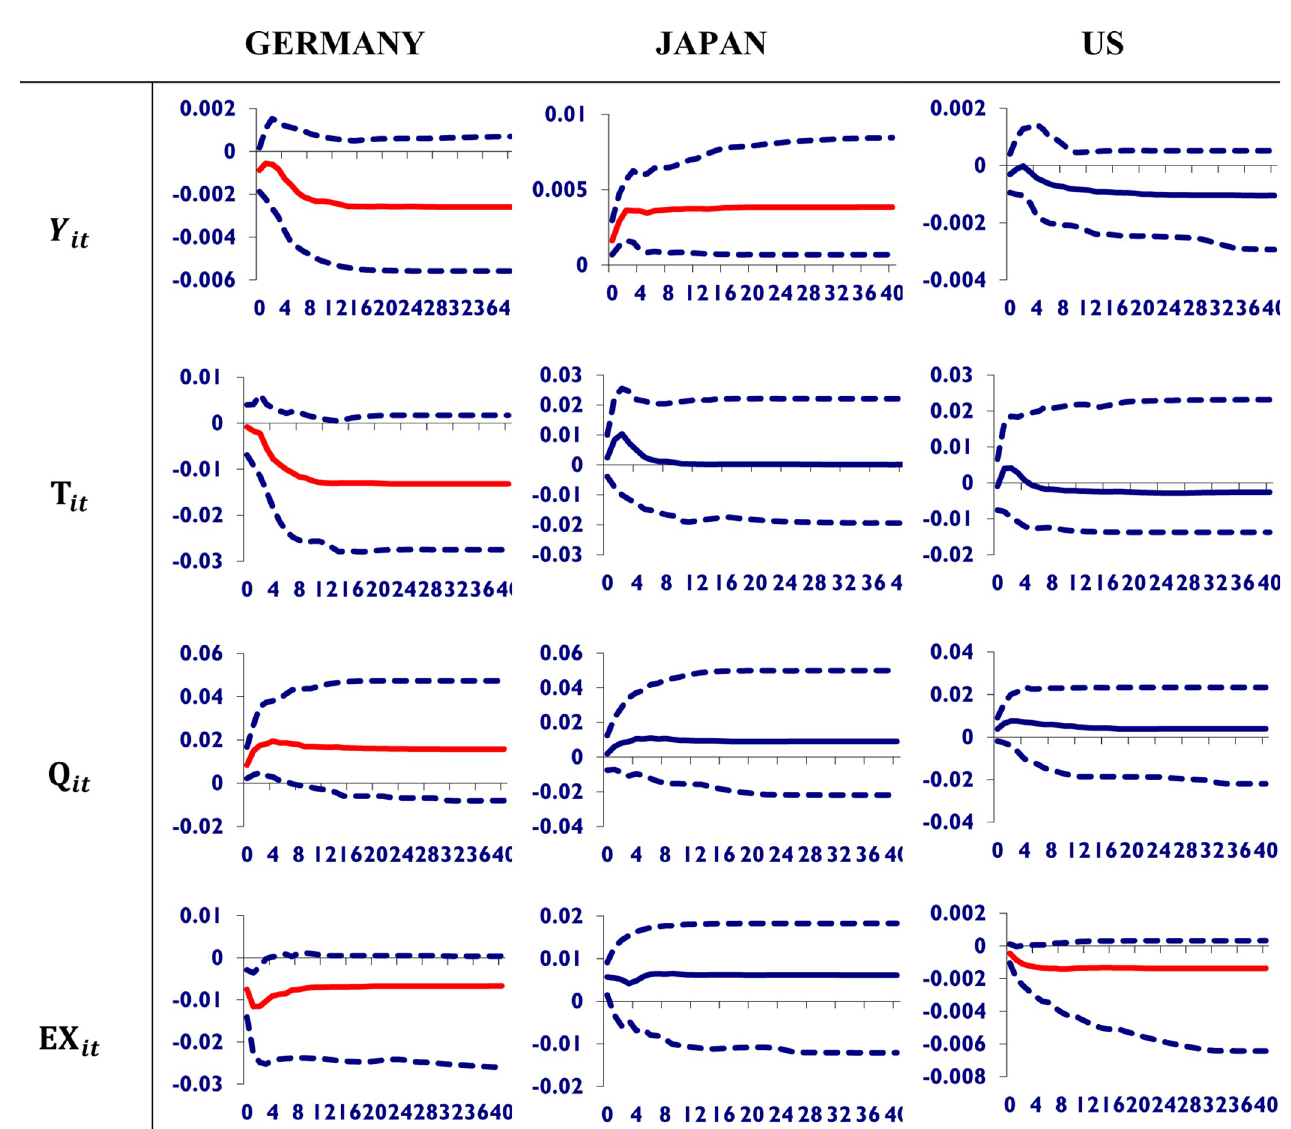
Fig 4. Shocks to Chinese stock prices and its impact on its trading partners economies. A shock to Chinese equity prices is more alarming for the German economy than the Chinese one because it permanently reduces its GDP, deteriorates its trade volume, appreciates its currency, and improves its stock prices. The Japanese economy seems to be doing well in terms of its GDP improvement. It also significantly appreciates the US currency.